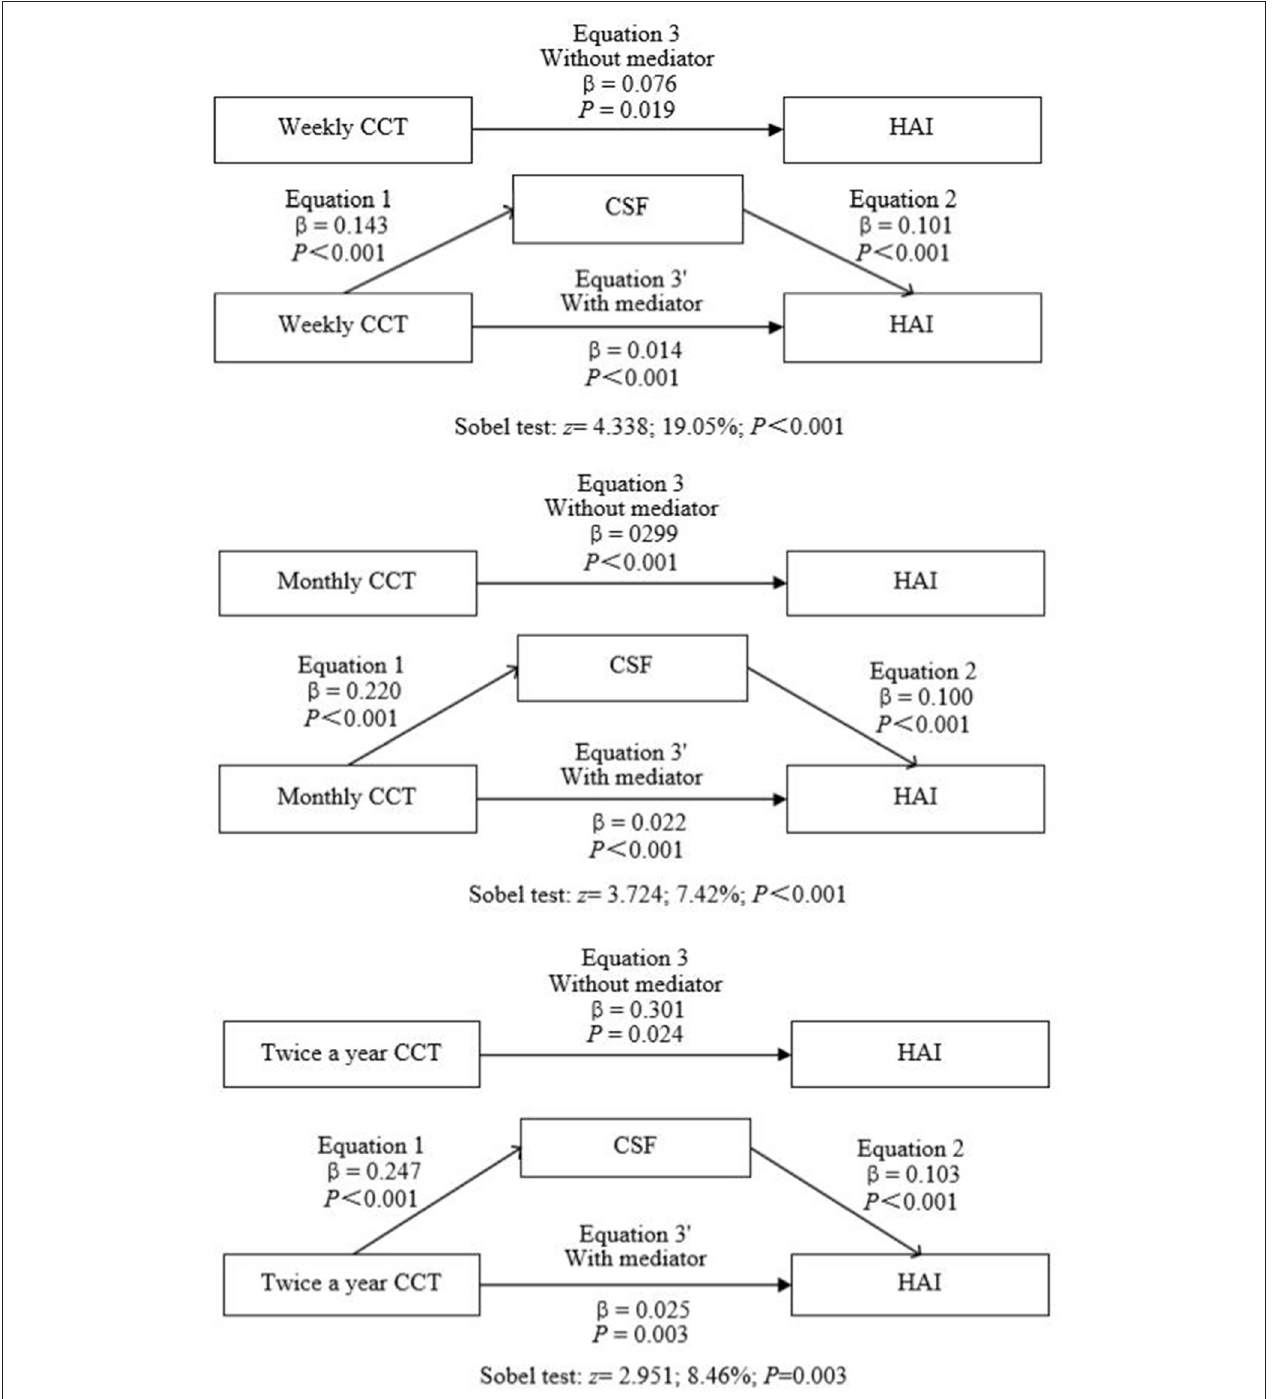
FIGURE 1 | Mediation analysis: contribution of child contact to healthy aging through parental satisfaction age 45 and over. CSF, Satisfaction with the relationship with children; HAI, healthy aging. The Sobel test was used to test the hypothesis that the indirect role was equal to 0, adjusting for potential confounders (age, gender, hukou status, residence, education levels, public health insurance cover, current work status, smoking, alcohol intake, self-report of health, chronic condition, consumption, live near children, number of alive children, gave money to children, and received money from children). Values are bolded if they achieved statistical significance at p ≤